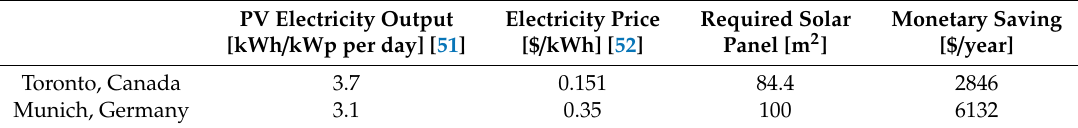
Table 7. Equivalent quantitative benefit of Tesla turbine (TT) exploitation. PV: photovoltaic.